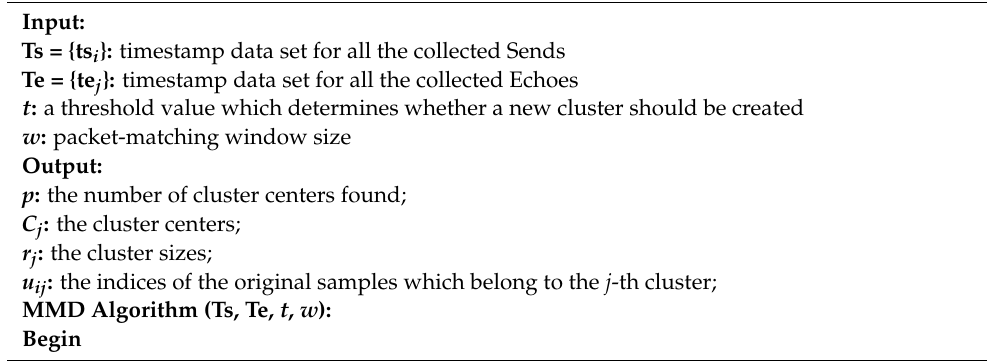
Algorithm 1 Matching Send and Echo